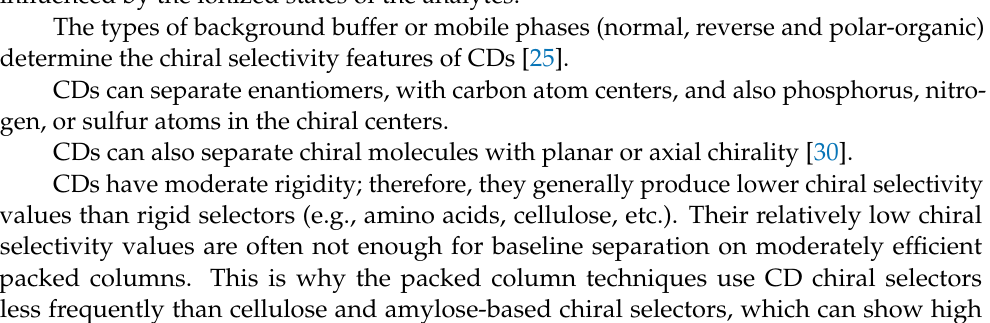
Figure 3. The real shape of derivatives of cyclodextrins is a twisted truncated cone, with various substituents, bond lengths, and directions around the chiral carbon centers.